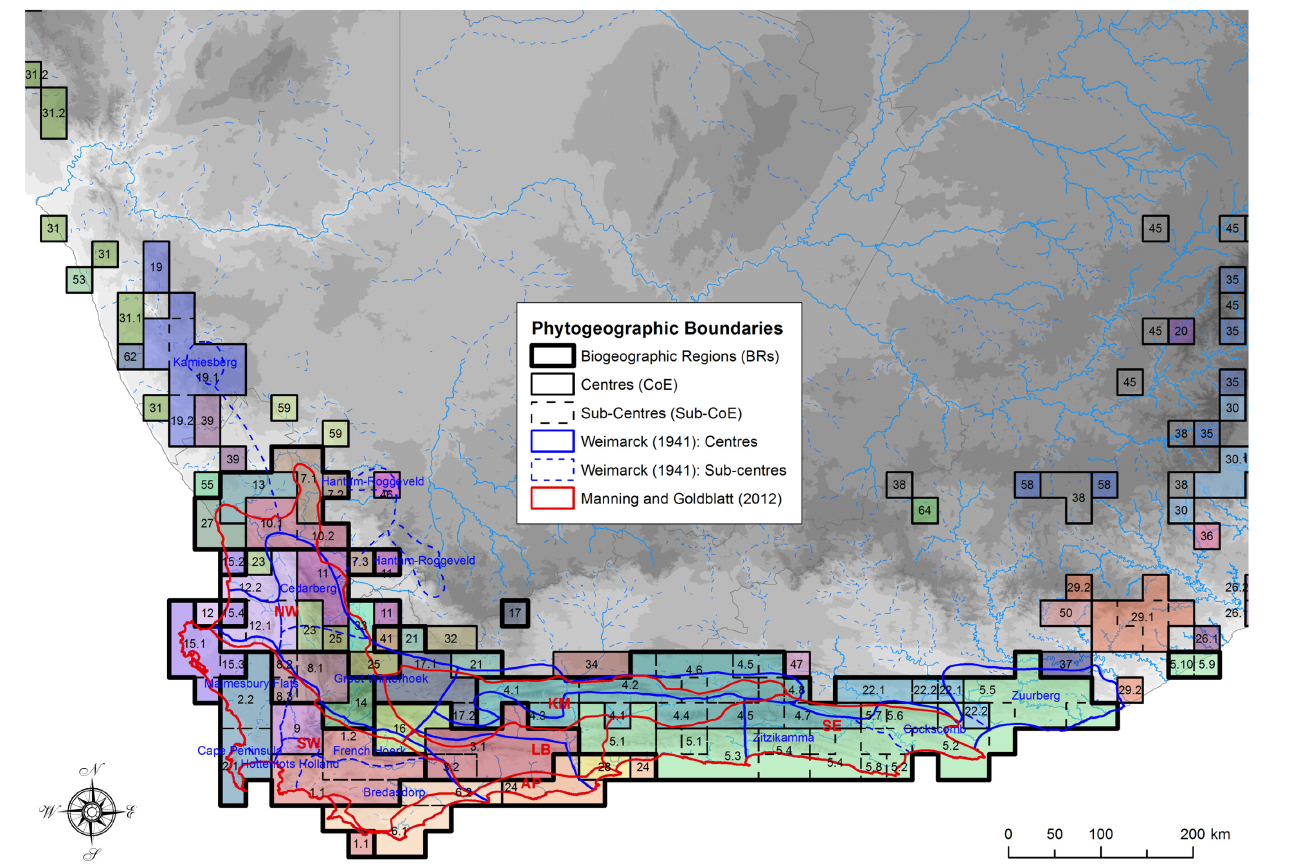
Fig 10. Our phytogeographic areas and those of earlier